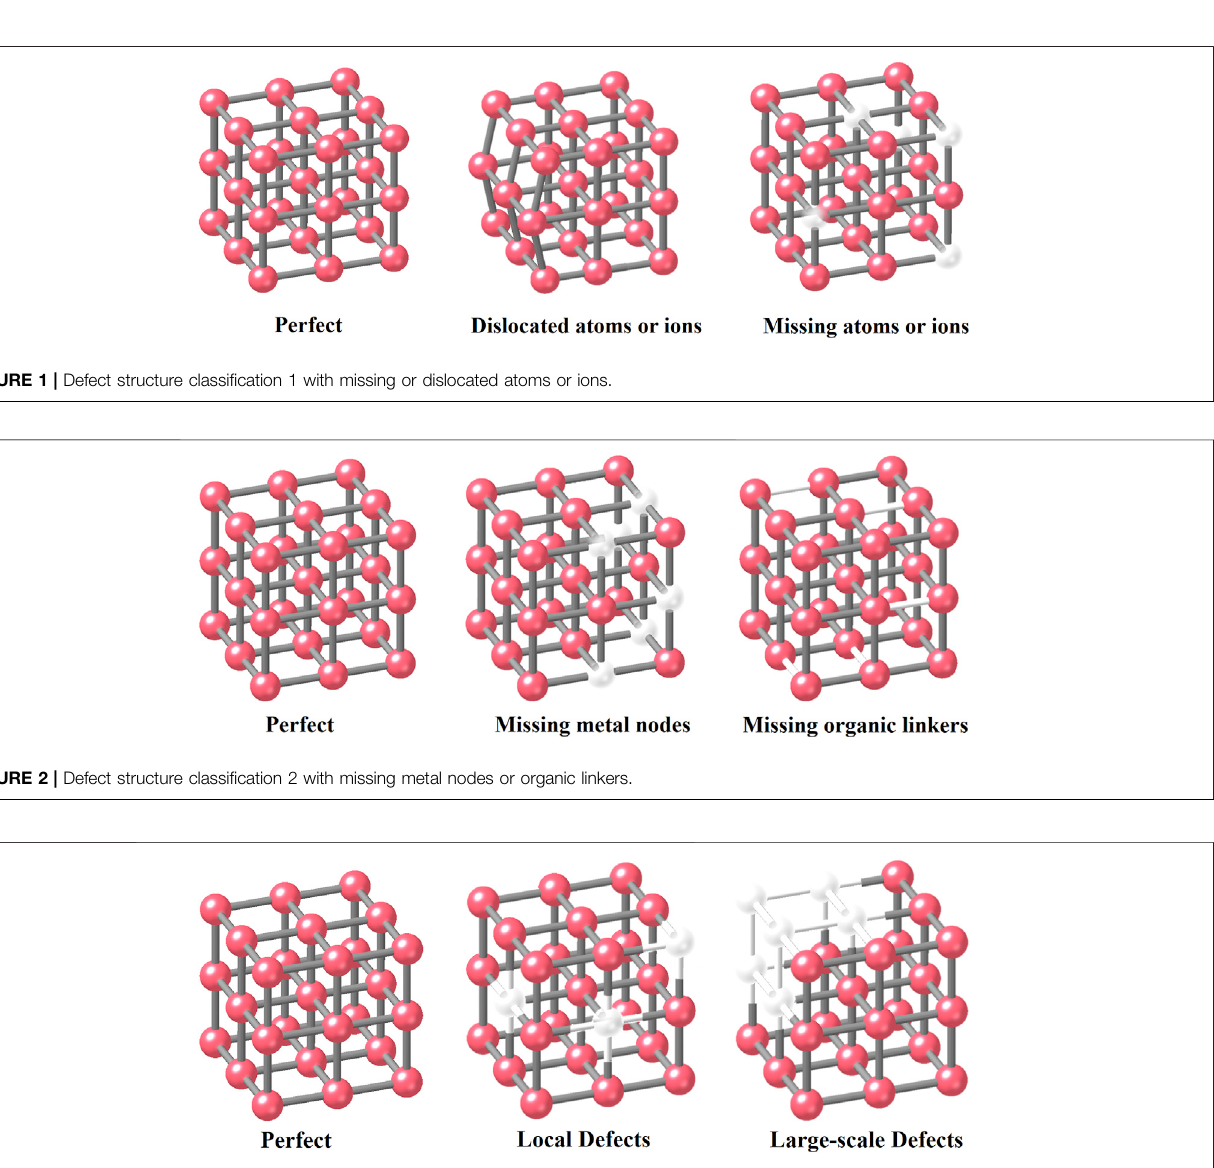
FIGURE 3 | Defect structure classi fi cation 3 with defect